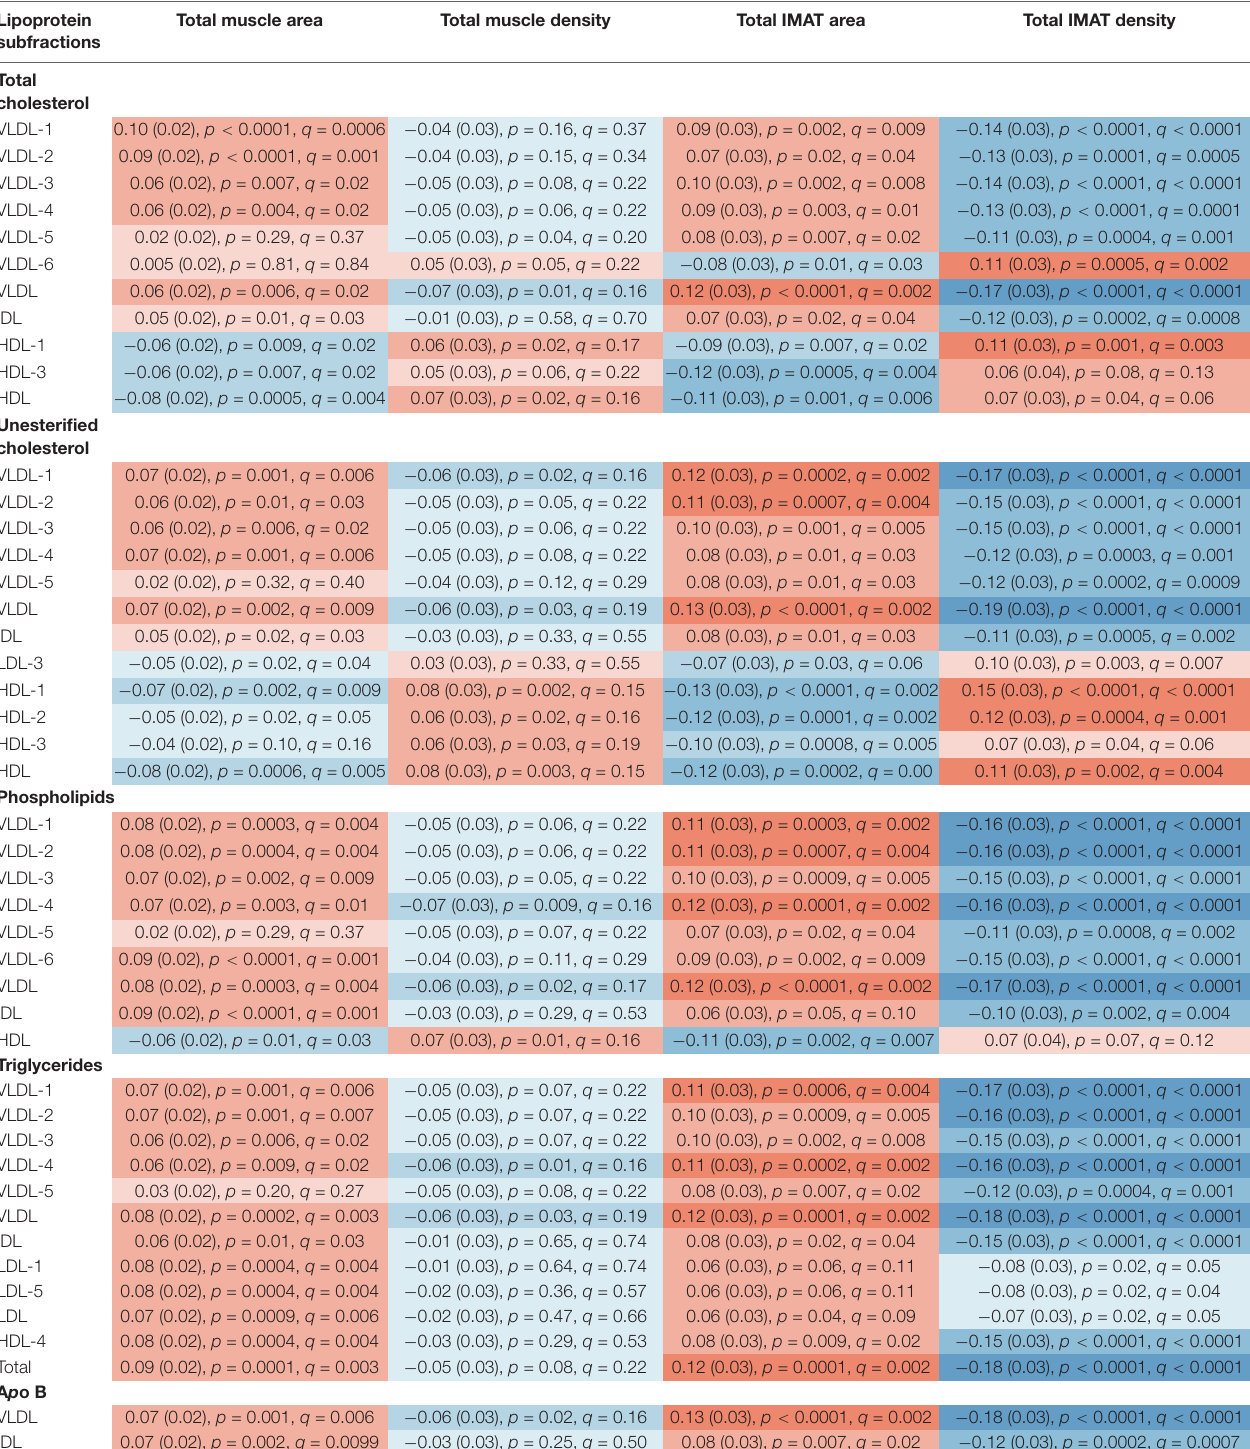
Associations were adjusted for age, gender, race, alternate healthy eating index, moderate-to-vigorous physical activity, sedentary behavior, and lipid-lowering medication use. Shading indicates adjusted standardized regression estimates ranging from: ≤– –0.20 & >